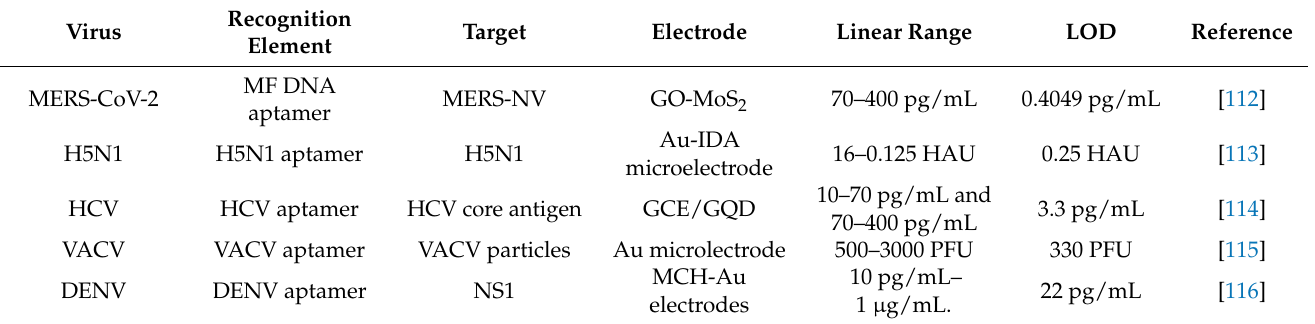
Table 2. Recently developed aptasensors for virus